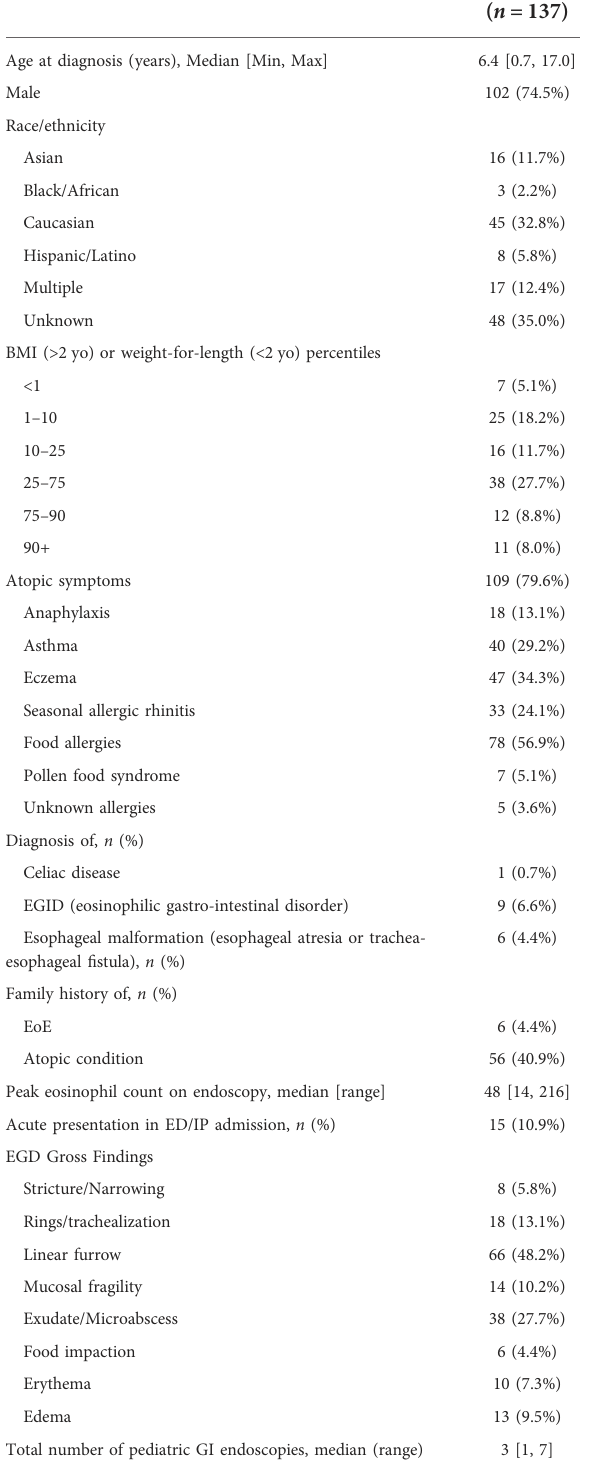
TABLE 1 Baseline